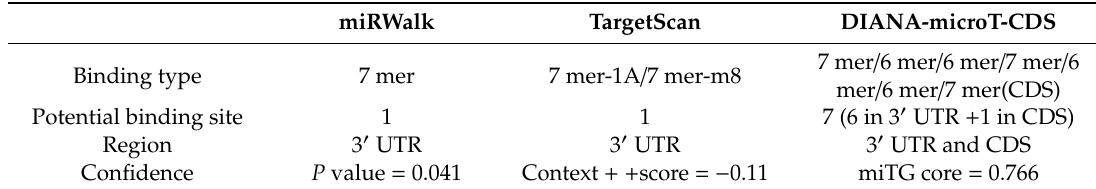
Table 3. Prediction of CASP9 as a target of miR1276 using three online programs.